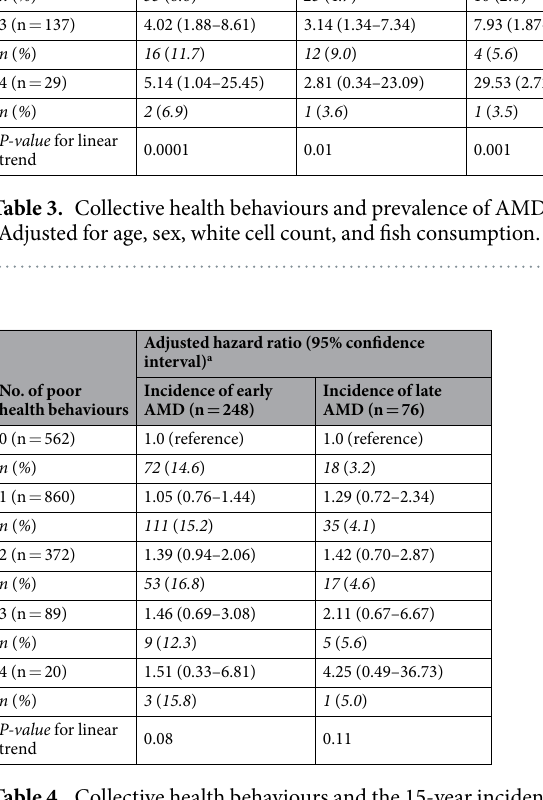
Table 4. Collective health behaviours and the 15-year incidence of AMD in the Blue Mountains Eye Study during 1992-4 to 2007-9 (n = 1903). a Adjusted for age, sex, white cell count, and fish